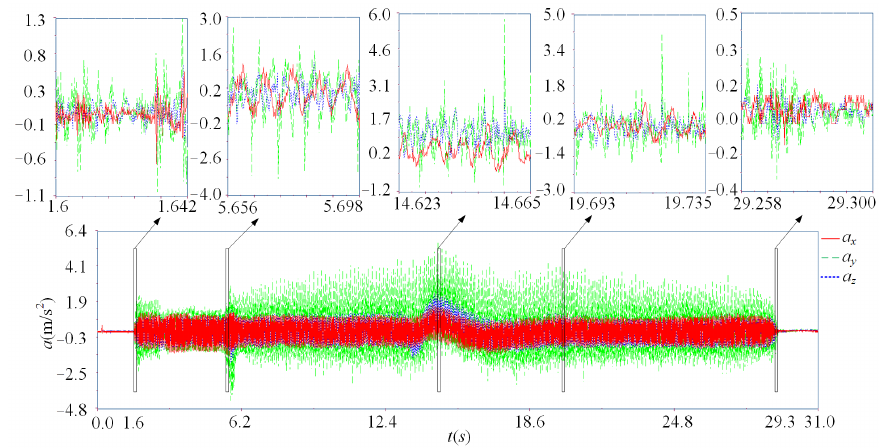
Figure 6. Milling vibration acceleration signal.